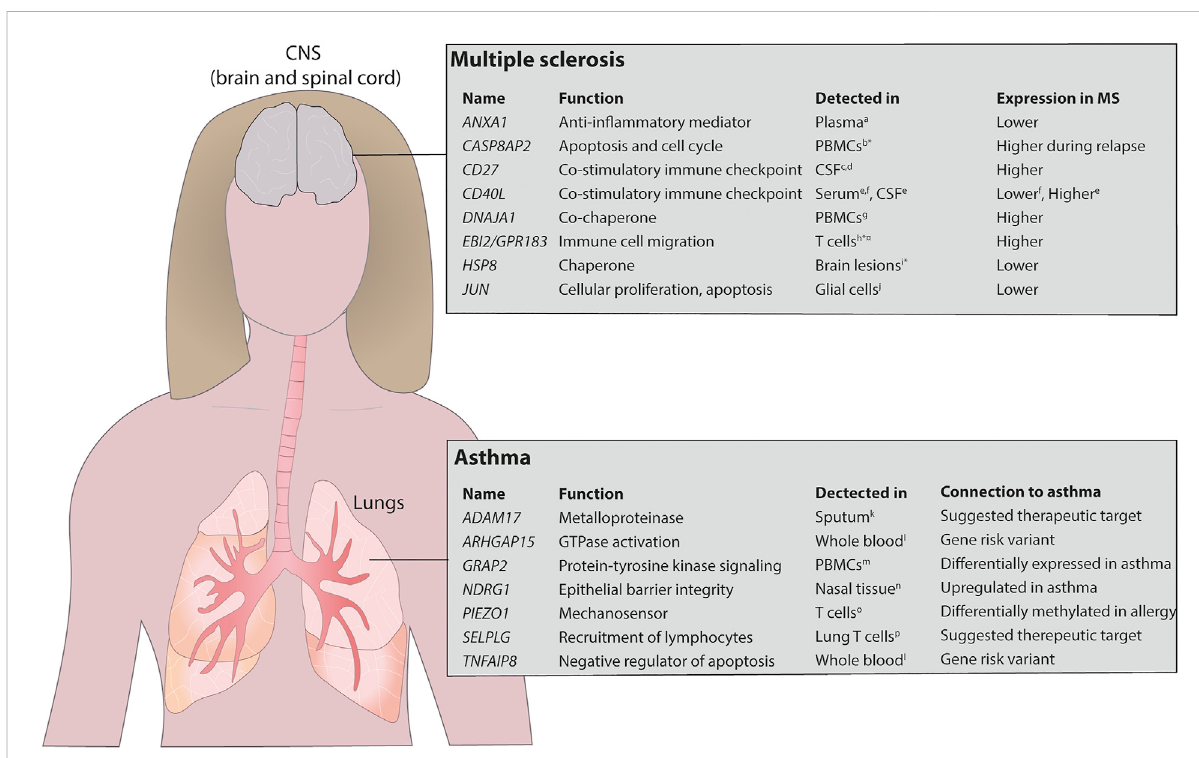
Overview of detected potential biomarkers in asthma and MS. The model identi fi ed several proteins that have previously been identi fi ed in MS and asthma. The upper panel shows the potential biomarkers identi fi ed in MS and the lower panel shows the same in asthma. *mRNA expression, ¤ identi fi ed in mice. PBMCs, peripheral blood mononuclear cells. References stated in the fi gure a Colamatteo A et al., J Immunol, 2019; b Achiron A et al., Ann N Y Acad Sci, 2007; c van der Vuurst de Vries RM et al., JAMA Neurol, 2017; d Wong YYM et al., Mult Scler, 2018; e Masuda H et al.,